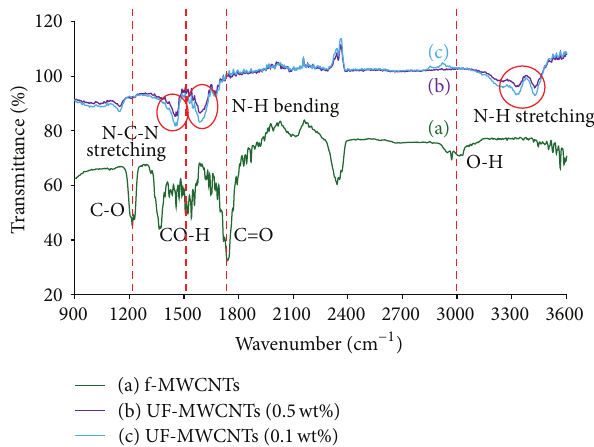
Figure 3: FT-IR spectra of (a) f-MWCNTs and UF-MWCNTs with (b) 0.5 wt% f-MWCNTs and (c) 0.1 wt%